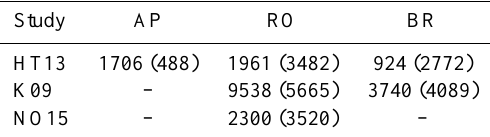
Table 2. Summary of average polynya-area estimates (km 2 ) from three studies – Haid and Timmermann (2013) (HT13), Kern (2009) (K09), and Nihashi and Ohshima (2015) (NO15). Corresponding re- sults of this study are given in parenthesis. MODIS estimates vary between studies due to different sample intervals of each compari- son study we tried to match in the best possible